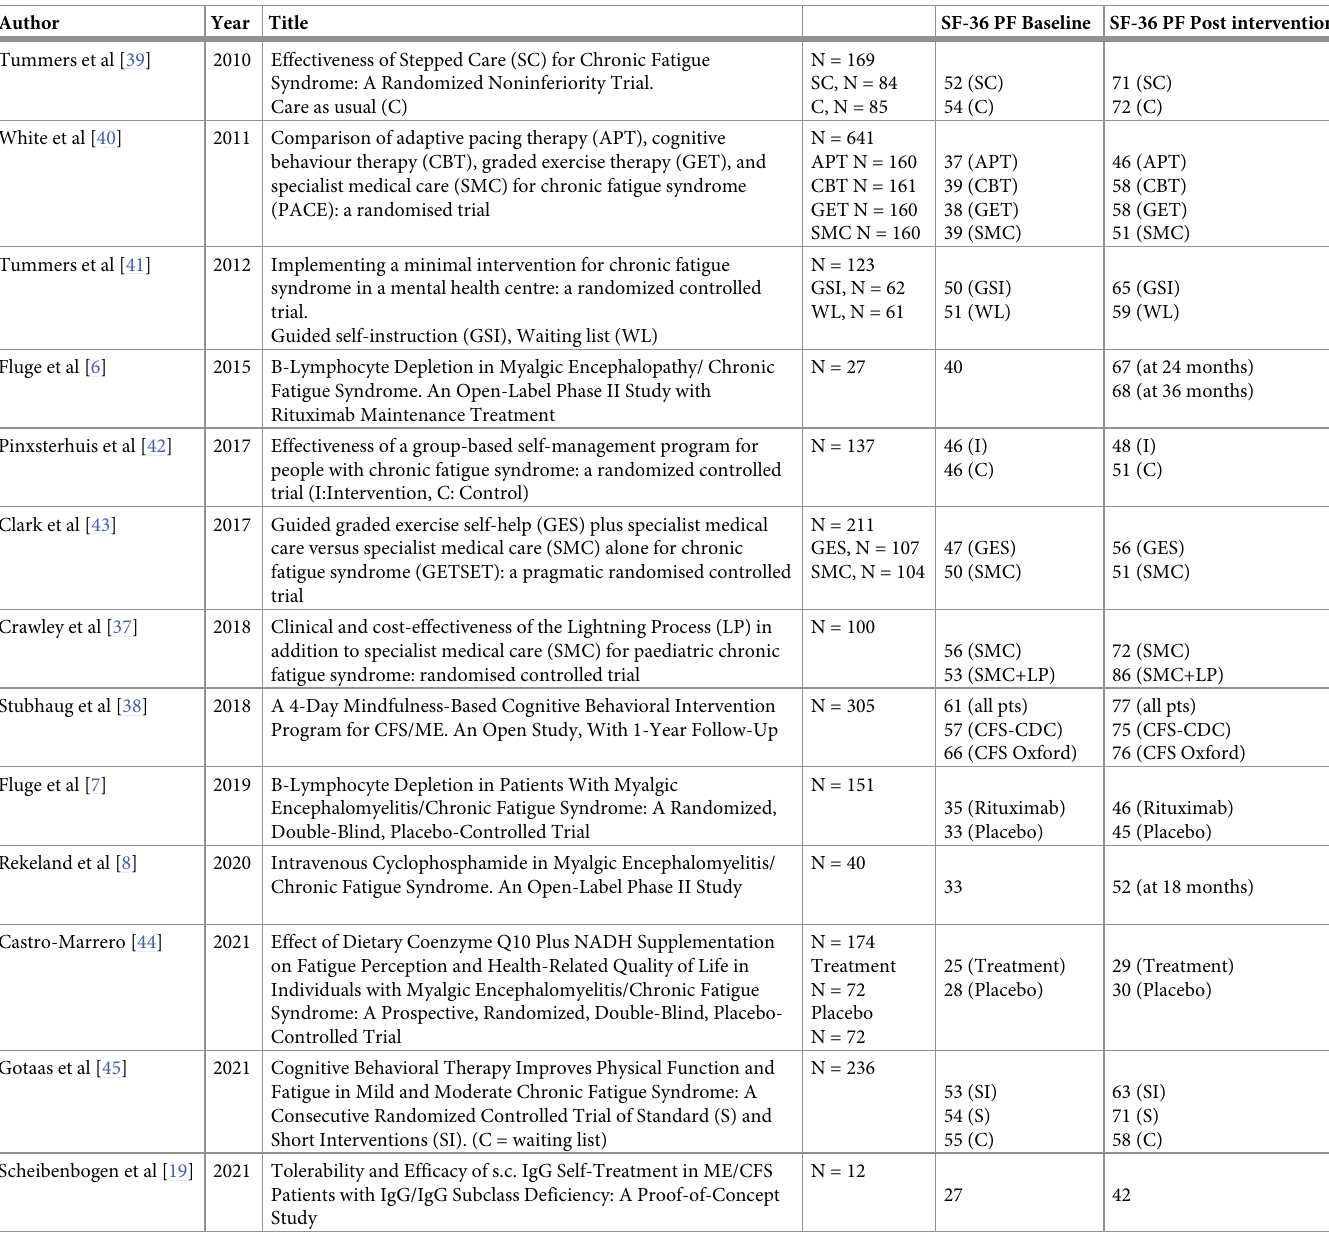
Table 3. Short Form-36 Health Survey, the domain “Physical Function” (SF-36 PF, raw scores, scale 0–100), in different ME/CFS studies.